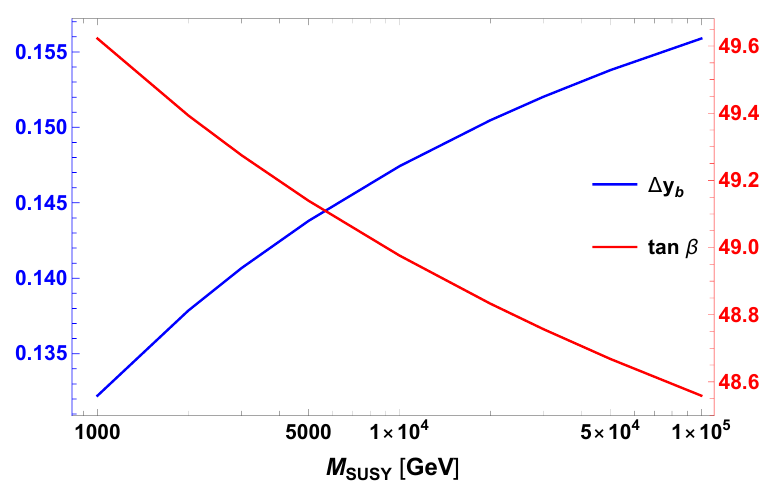
Figure 1 . Dependence of the required SUSY threshold correction (cid:1) y b and tan (cid:12) for realizing the SO(10) Yukawa uni(cid:12)cation on M SUSY . The blue line and axis show the result for the required SUSY threshold correction, and the red ones show the result for the tan (cid:12)